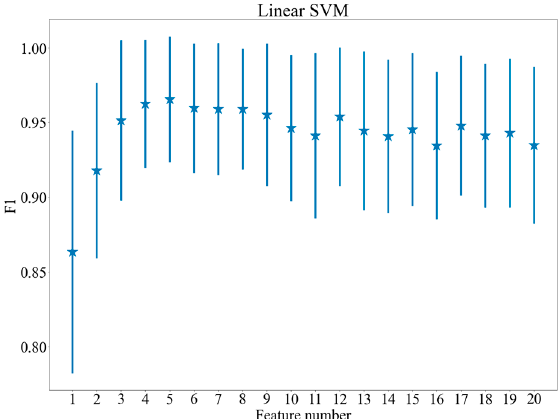
Figure 6. F1 scores for various feature numbers. Linear Support Vector Machines (Linear SVM).